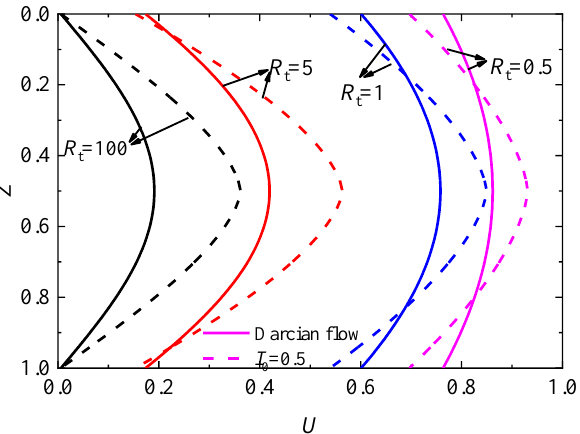
Figure 6. Darcy and non-Darcian flows under a double-sided impeded drainage boundary ( R b = Rt, T = 0.2).